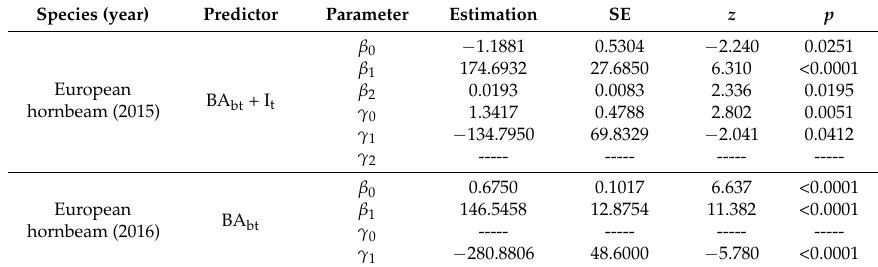
Table 6. The parameter estimates for the best model fit of the number of dead new sprouts.